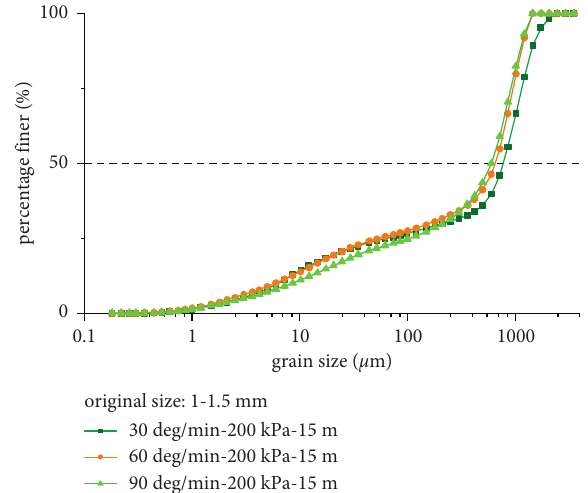
Figure 6: Cumulative grain-size distribution curves after shearing at 15m at the shear rates of 30 deg/min, 60deg/min, and 90deg/ min under a normal stress of 200